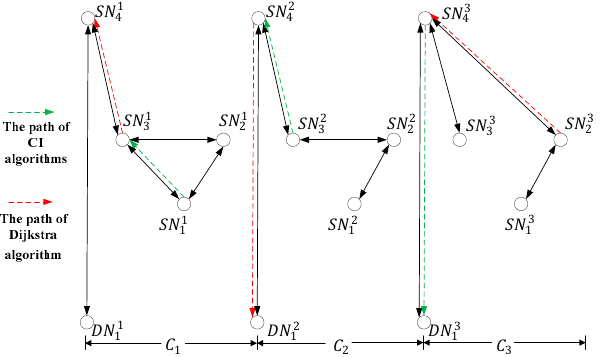
Figure 3. Analysis of CPD Problems in an example space network.